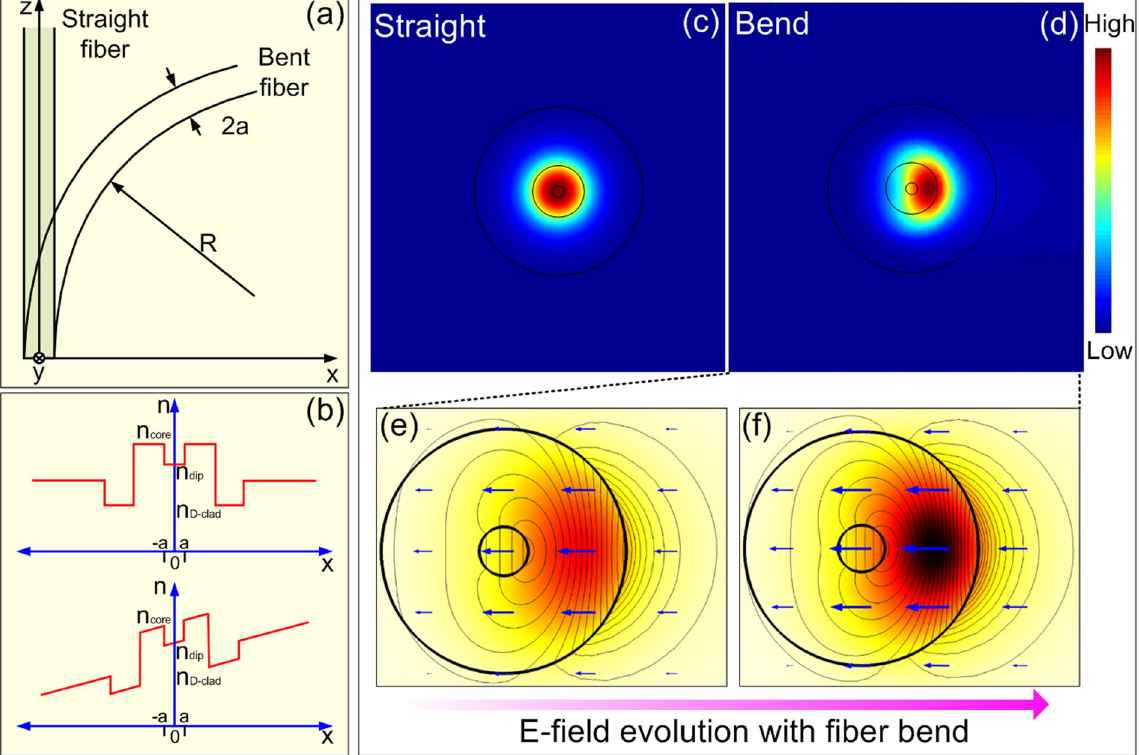
Figure 7. ( a ) Schematic of a circularly bent fiber, ( b ) Refractive index distribution of an unstressed (up), bent fiber (down), ( c ) E-field distribution of straight fiber, ( d ) E-field distribution of bent fiber in a certain degree, and ( e ) and ( f ) magnified schematic evolution of the fundamental mode with fiber bend (the average power of the E-field is forced to move out the fiber dip and eventually loss out